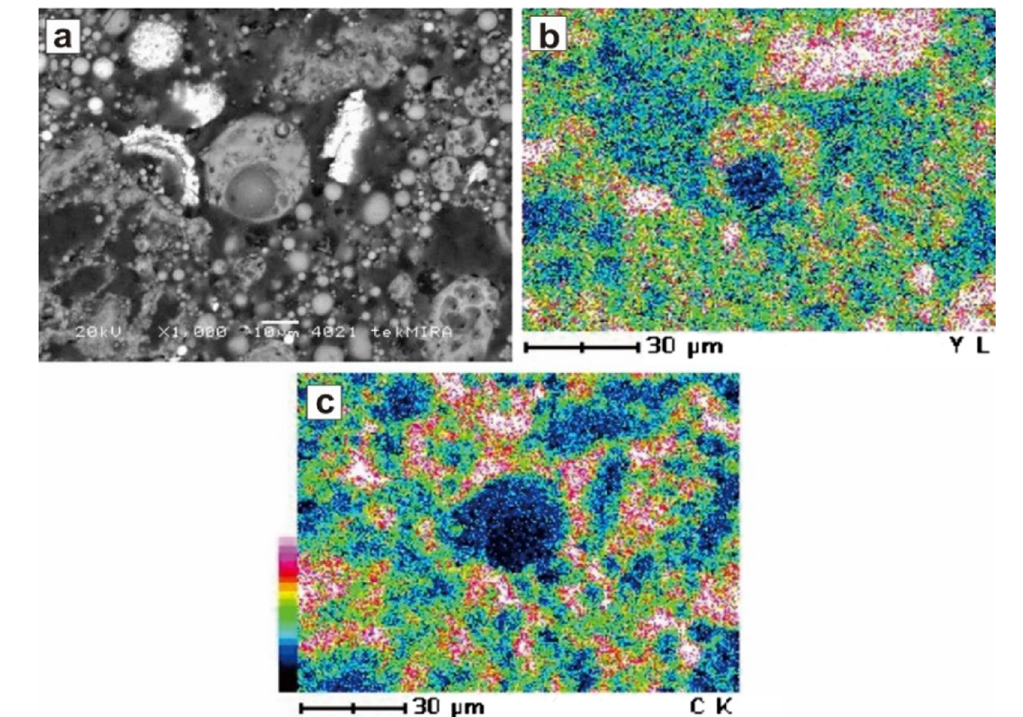
Fig. 11 Comparison of the mode of occurrence Y and major elements C composed organic components in FA-4 based on SEM-EDX images. a backscattered electron image, x1000; elemental mapping shows the distribution of Y ( b ) and the region rich in C ( c )